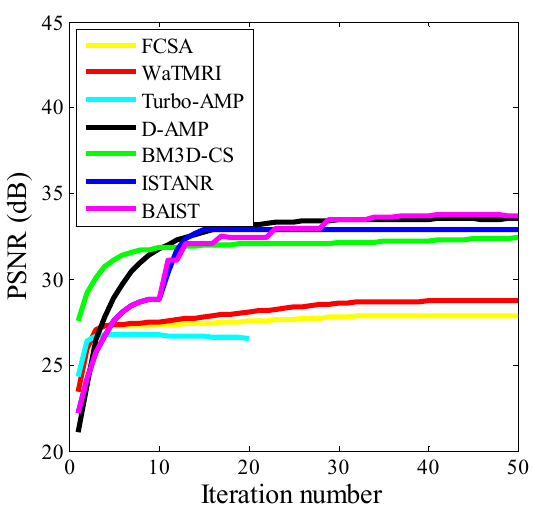
Figure 6. Iteration no. vs. PSNR on boat image with 20% sampling.